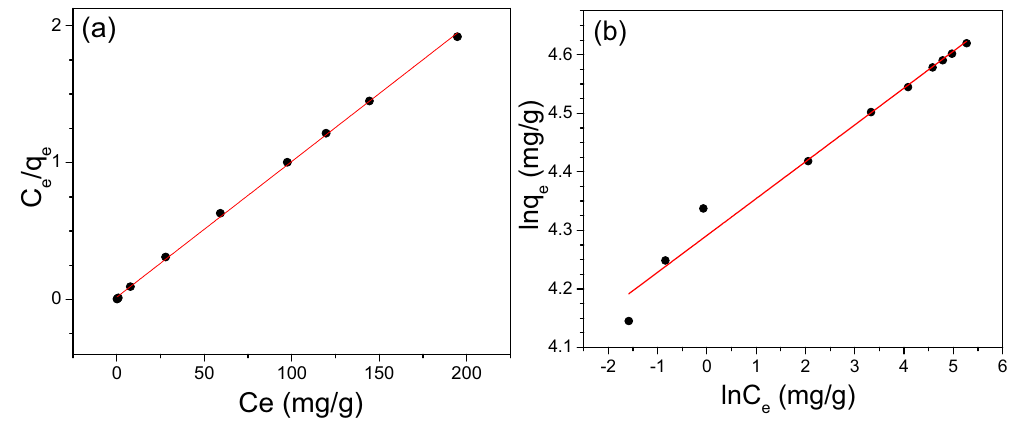
Figure 6: Adsorption isotherms of SO 42− adsorption by ET2.0 of ( a ) Langmuir and ( b )